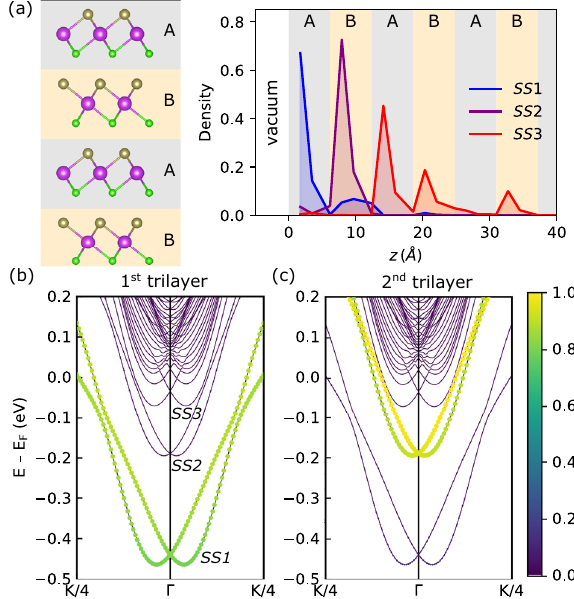
Fig. 4 Spatial extent of the surface states. a Plots of the calculated surface state wavefunctions at k = 0, showing that the fi rst and second states are largely localized to individual trilayers. b , c Band structure plots, with colors representing the projections onto the fi rst and second trilayers,